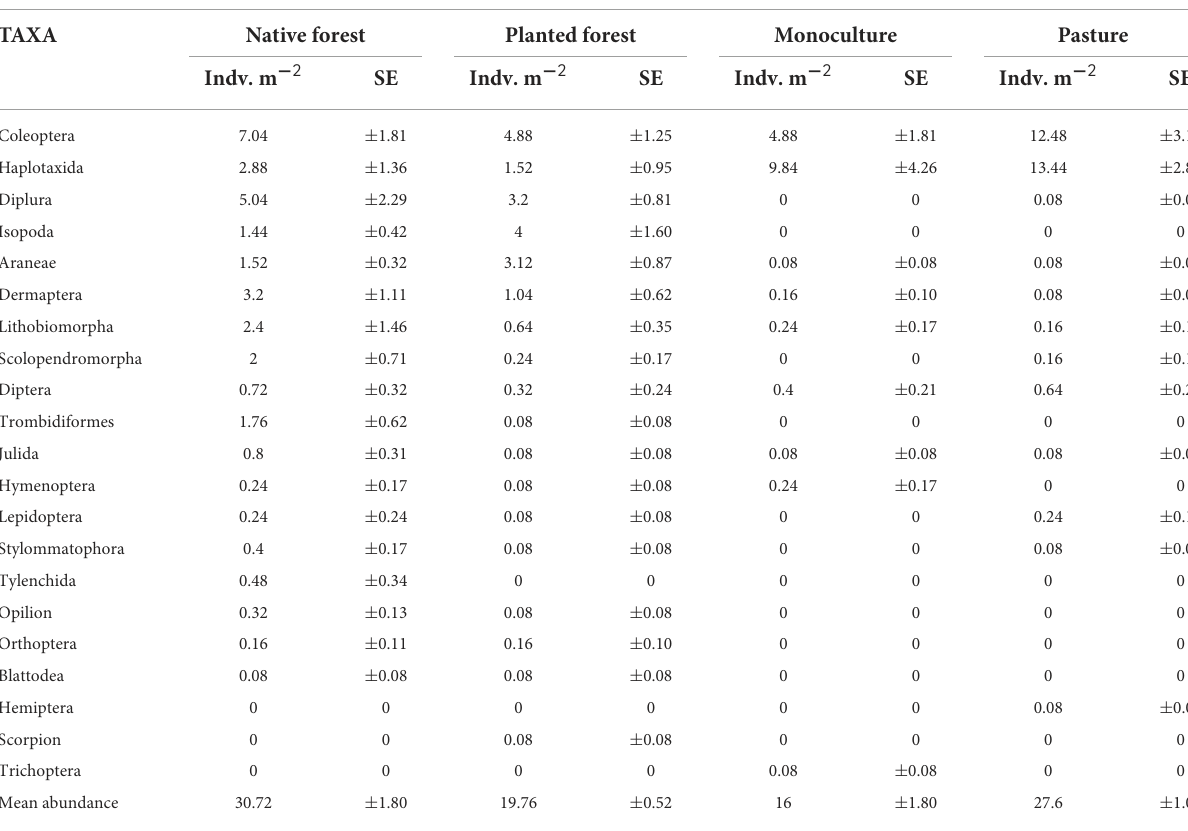
TABLE 1 Abundance (mean ± standard error) of soil macroinvertebrates at order level across different land use